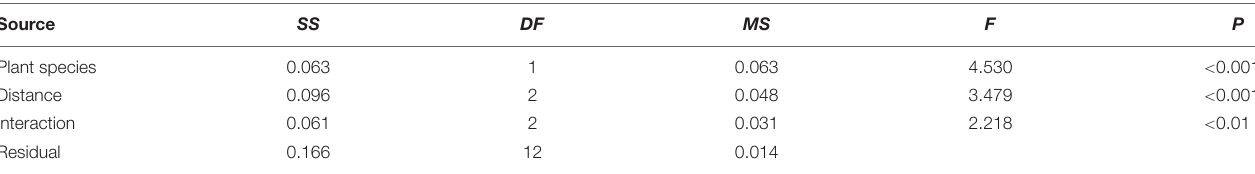
TABLE 4 | Permutational multivariate analysis of variance (PERMANOVA) results of soil bacterial community based on 16S rRNA gene sequencing, influences of plant species and